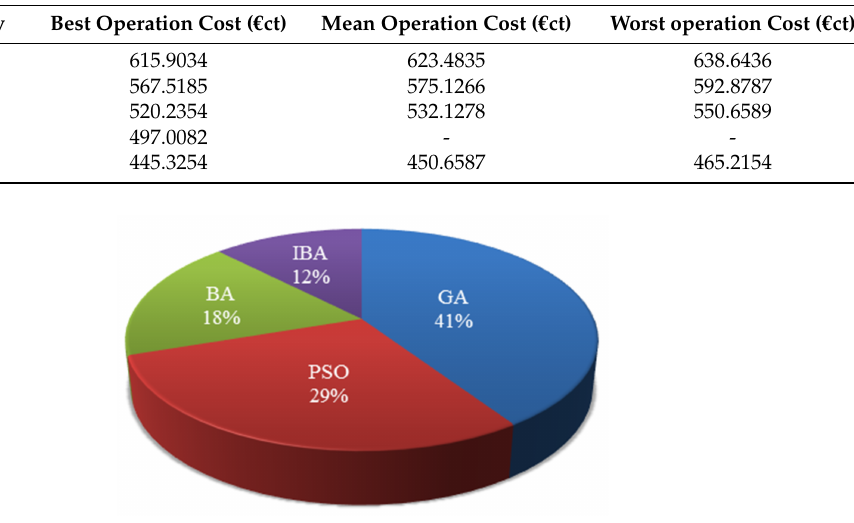
Figure 12. GWO cost saving compared with other algorithms in Scenario